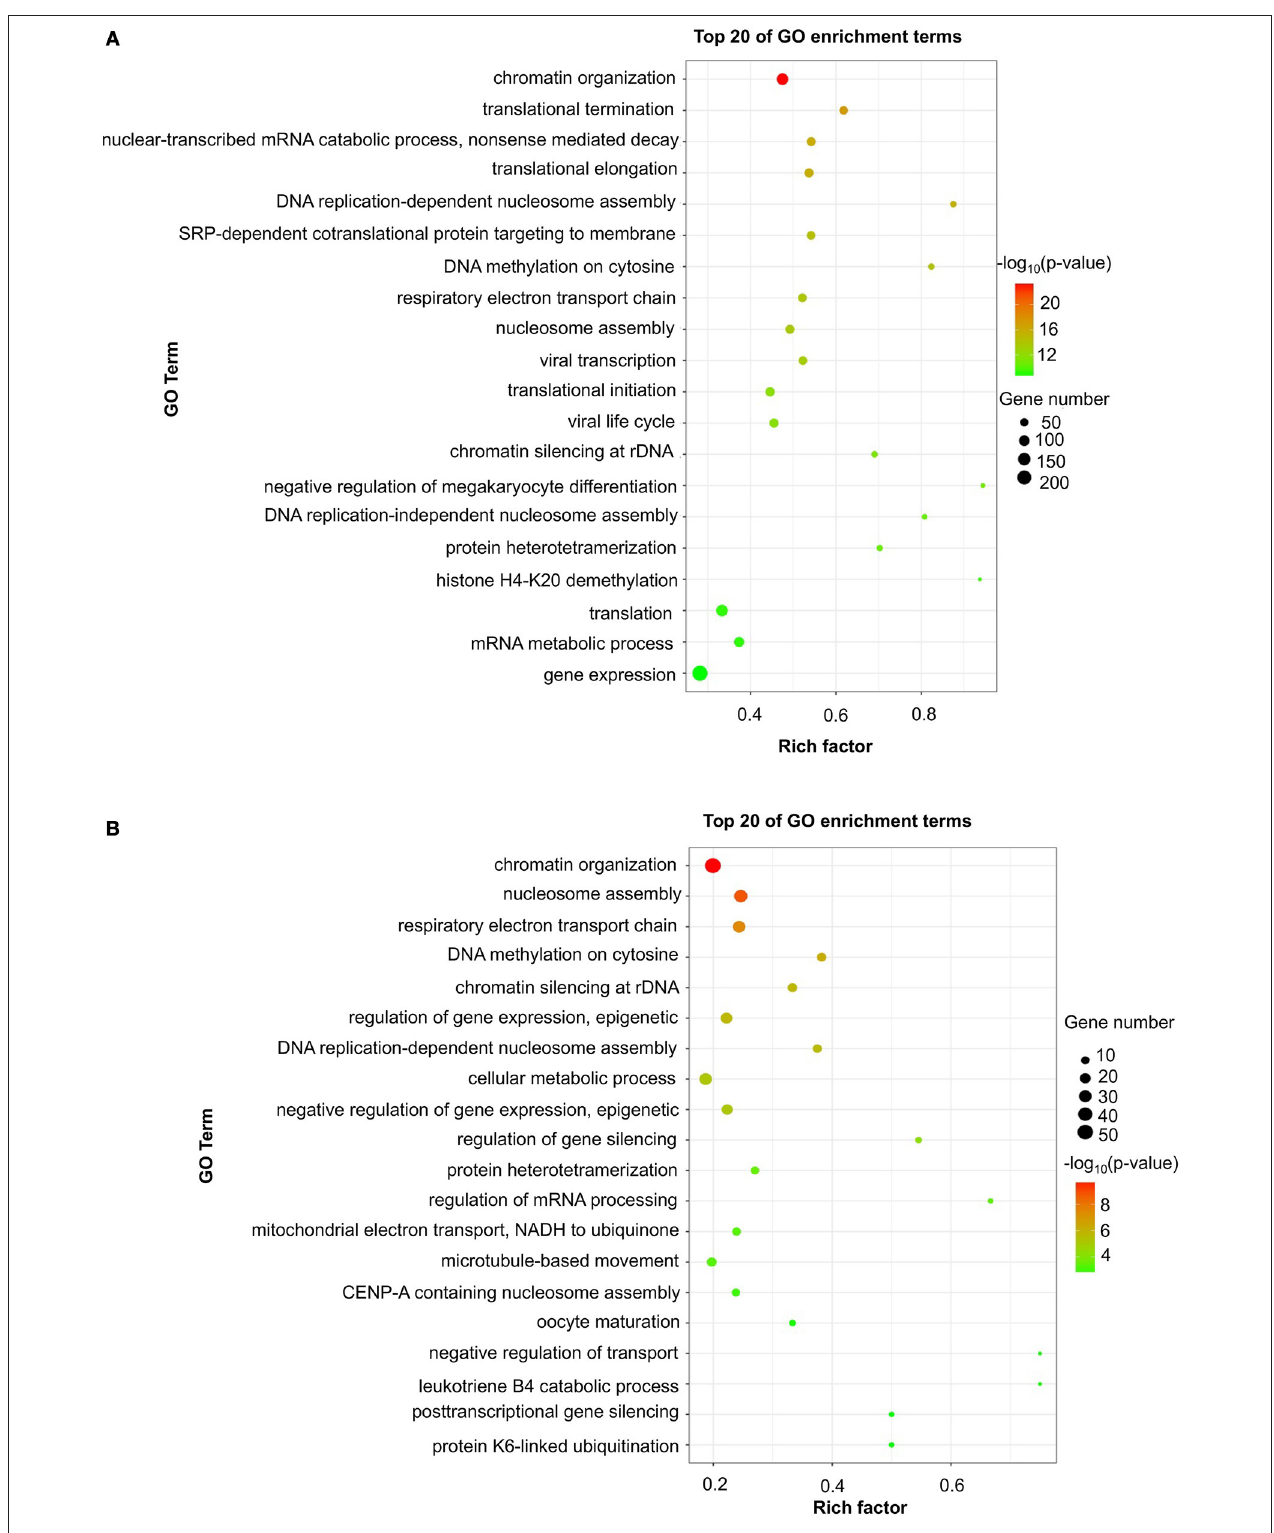
FIGURE 2 | GO enrichment of differentially expressed mRNAs. Significantly enriched Gene Ontology (GO) terms of differentially expressed mRNAs in patients at 24h (A) and 7 days (B) after stroke. The y-axis shows GO terms, and the x-axis presents counts of differentially expressed mRNAs in IS patients enriched for GO terms. The color scale represents the –log P-